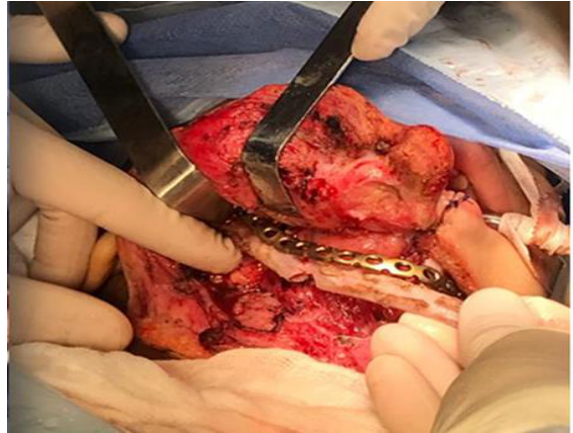
Fig. 4. Close view of the surgery, hemimandibulectomy with disarticulation, and costal graft with plate osteosynthesis.